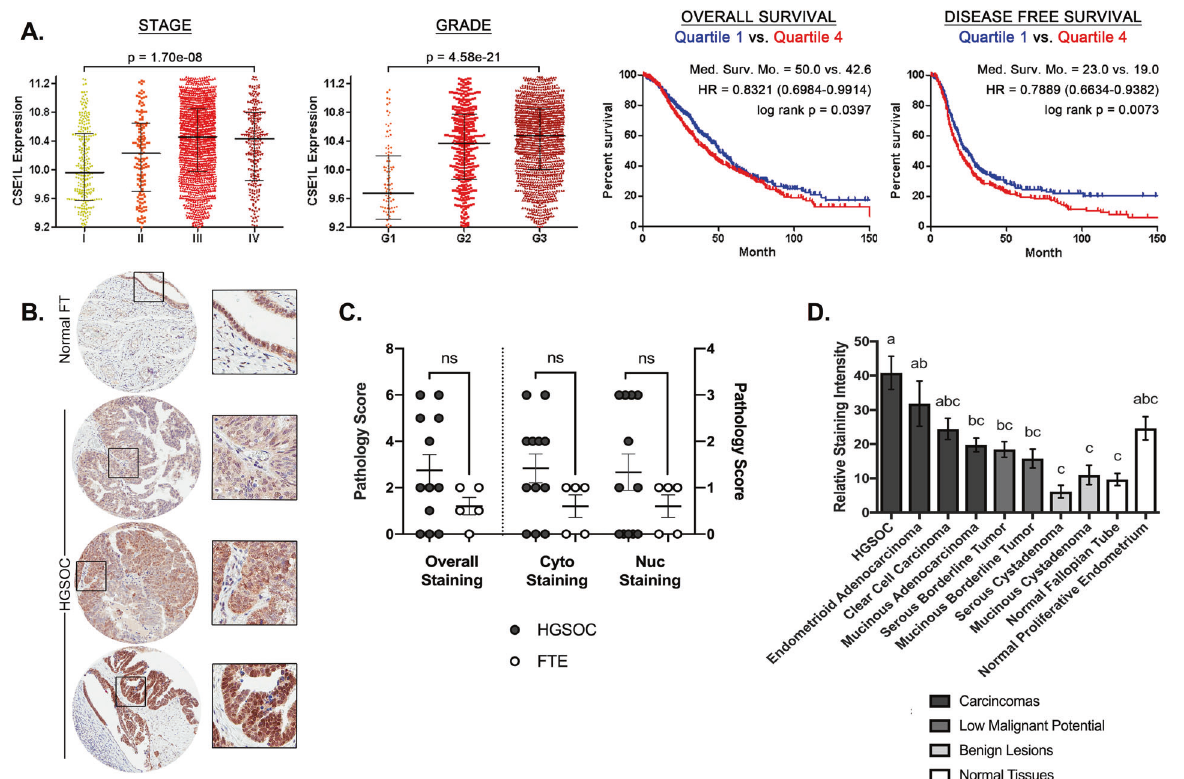
Fig. 2 CAS is a promising drug target as evidenced by patient sample analysis. A Cancer Science Institute of Singapore Ovarian Cancer Database (CSIOVDB) ovarian cancer patient data of CAS expression correlated to stage and grade ( n = 3431), overall survival ( n = 1868), and disease-free survival ( n = 1516). The 25% of patients with lowest expression (Quartile 1, blue) is compared to the 25% of patients with highest expression (Quartile 4, red) for survival data. HR = hazard ratio. B Representative images for TMA staining for CAS. C TMA scoring by two independent pathologists, averaged. Statistical comparisons between HGSOC and FTE pairs were assessed with unpaired t -tests. ns = not signi fi cant. D Quanti fi cation of staining intensity for TMA samples ( n = 6 – 12 patients per group). All groups were compared to each other with a one-way ANOVA with Tukey ’ s multiple comparison. Means that do not share a letter are statistically different ( p <